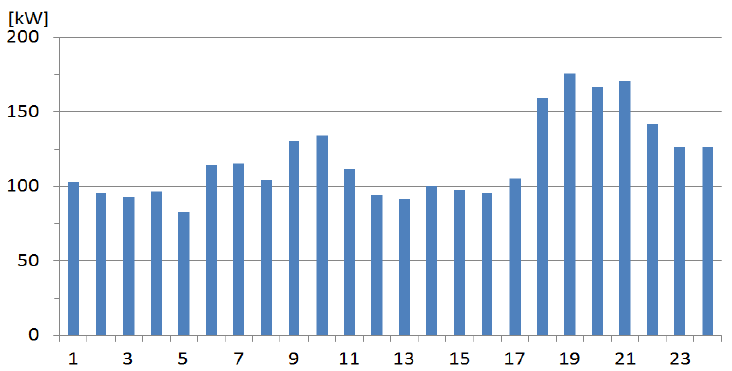
Figure A1. Weather Data of Test Island [26].